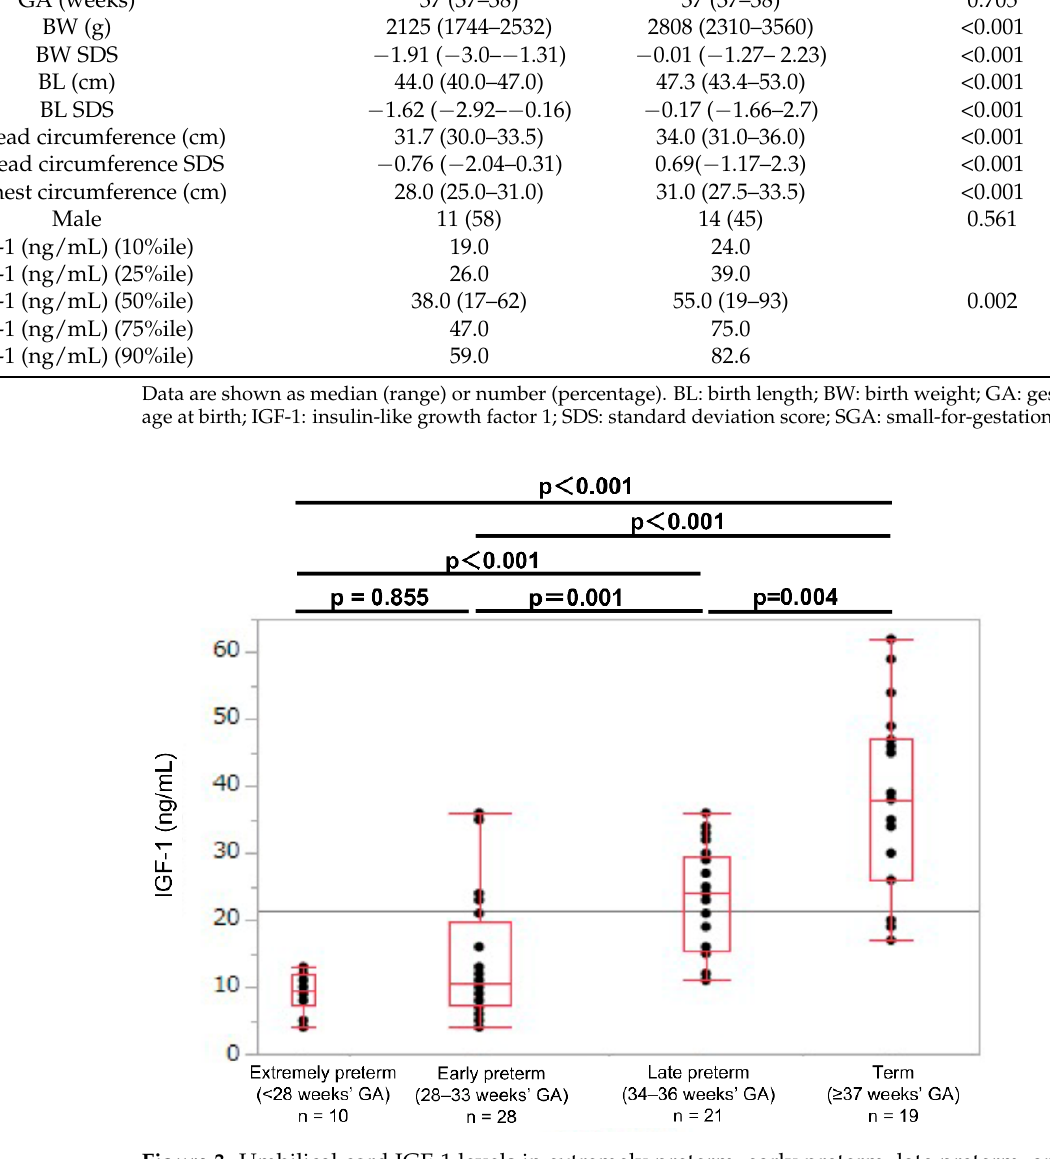
Figure 3. Umbilical cord IGF-1 levels in extremely preterm, early preterm, late preterm, and term SGA newborns. GA: gestational age at birth; IGF-1: insulin-like growth factor 1; SGA: small-for- gestational-age.